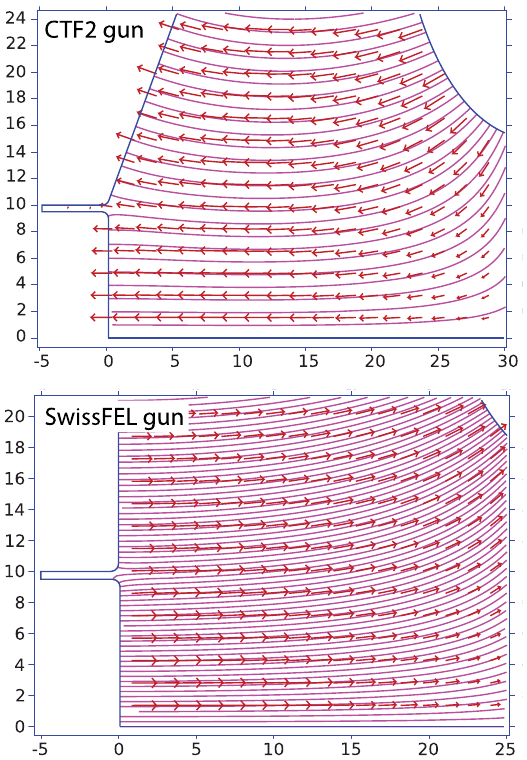
FIG. 7. Electric field pattern of the CTF2 and the SwissFEL gun obtained from numerical simulation. The axes are in mm.